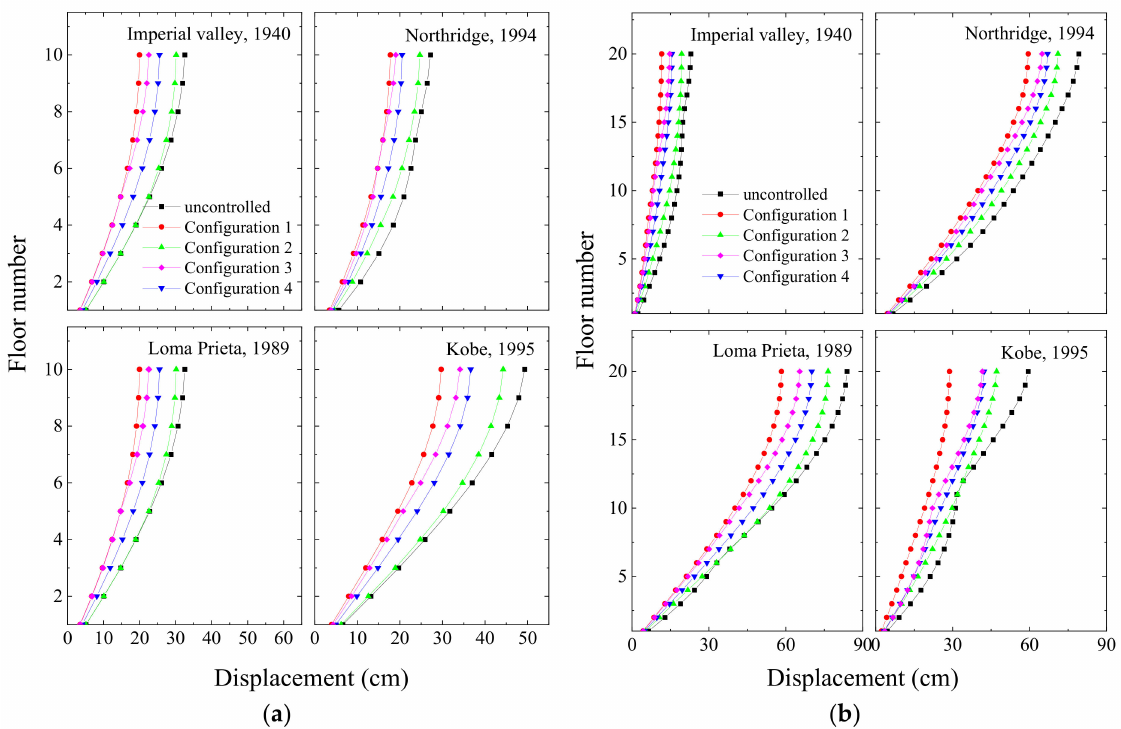
Figure 14. Peak floor displacement under different damper configurations in: ( a ) a coupled stiff building and ( b ) a coupled flexible building under semi-active control of the MR damper.